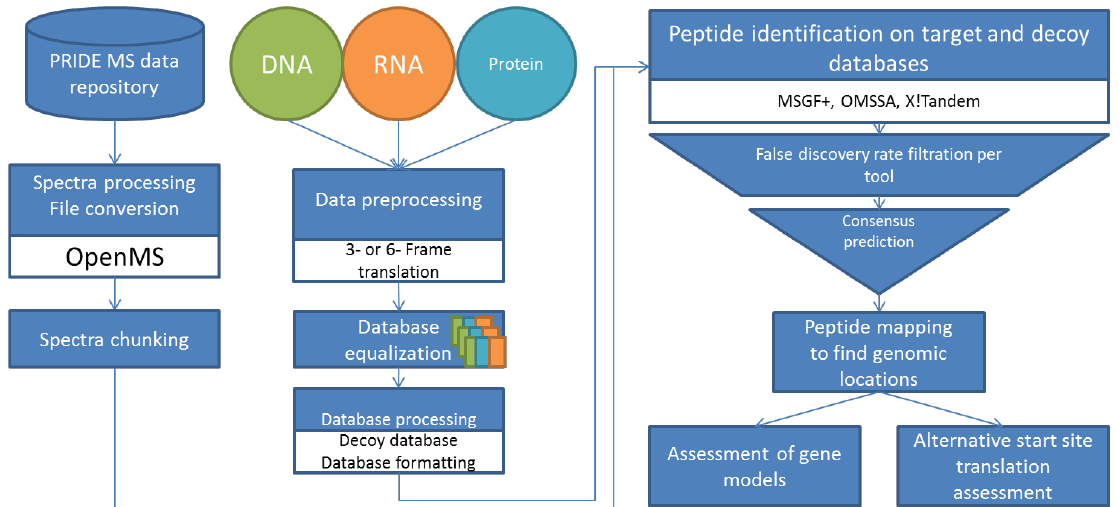
Figure 1 Overview of the PGMiner workflow. MS data can be directly acquired from PRIDE as can sequence data from, if available on ncbi. MS data and sequences can be packaged for parallel processing and peptide identification can be performed by three database search tools (MSGF+, OMSSA, and X!Tandem at the moment. Novel features are the automatic assessment of gene models and selected analysis of alternative translation start